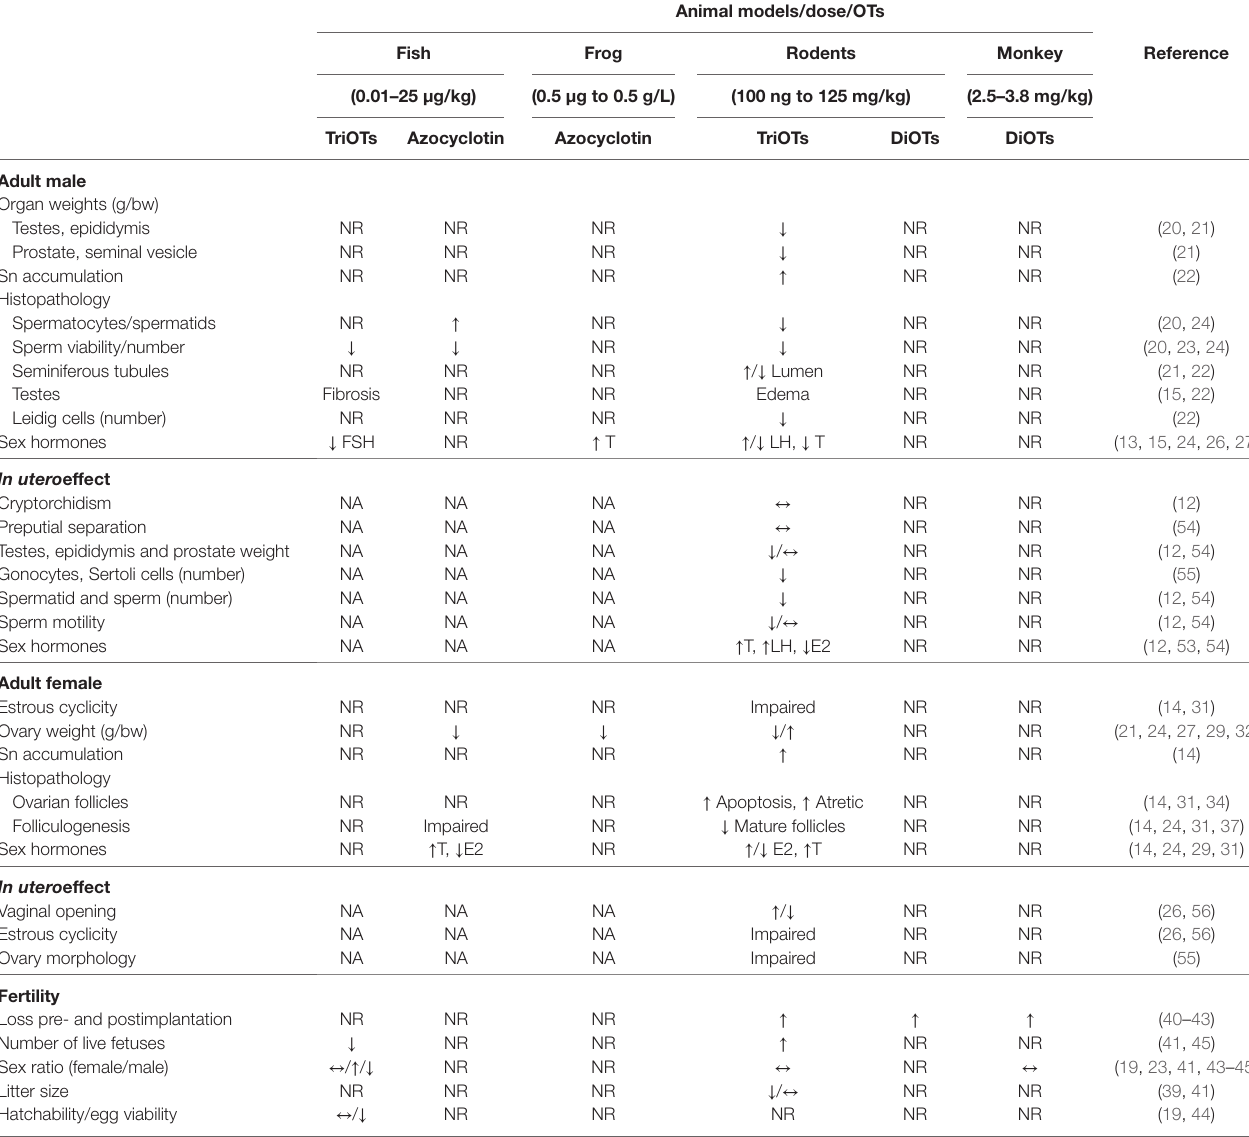
TAble 1 | Summary of vertebrate reproductive changes induced by